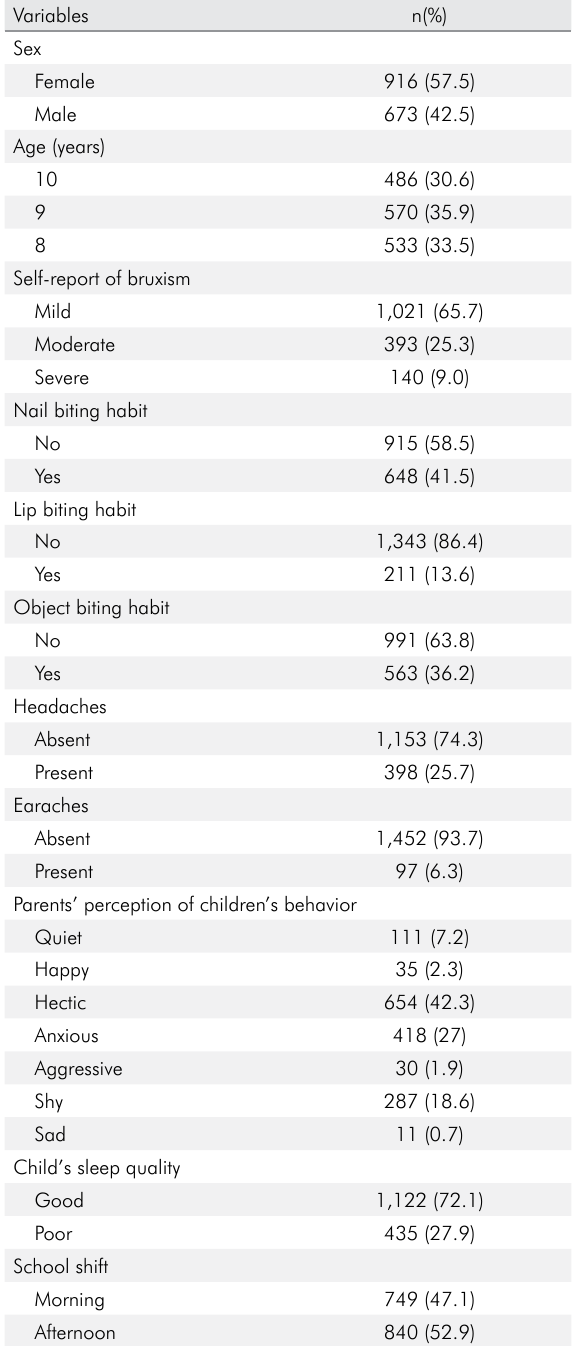
Table 1. Descriptive data, Florianopolis/SC, Brazil. (n =